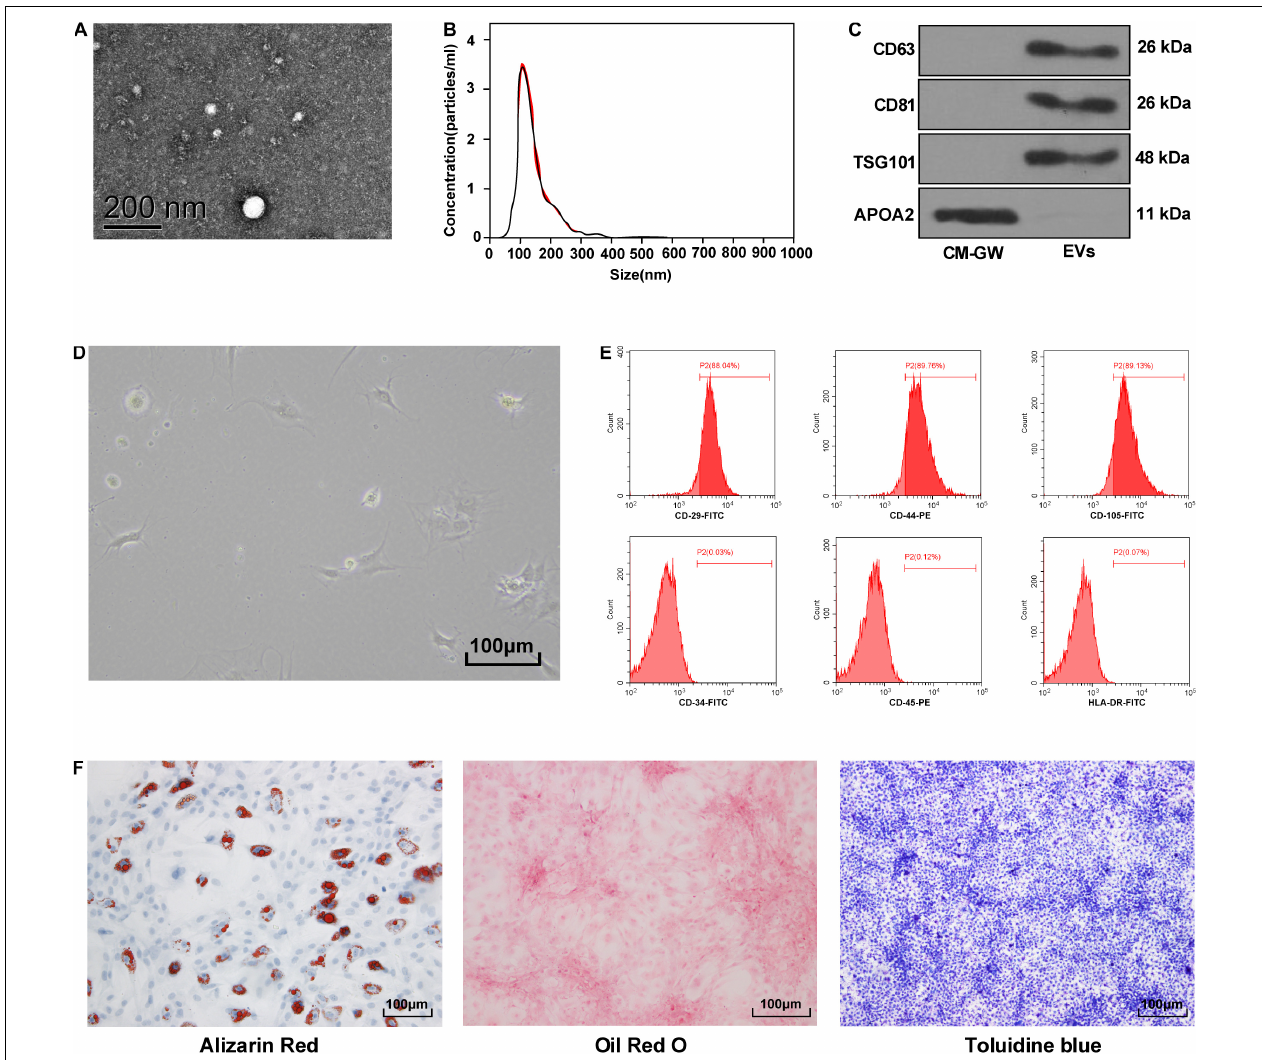
FIGURE 1 | Identification of BMSCs and hepatoma cell-derived EVs. (A) The morphology of EVs was observed by transmission electron microscopy. (B) The size and concentration of EVs were analyzed by nanoparticle tracking, the size was 110 ± 11 nm; the concentration was 4 × 10 6 particles/mL. (C) Western blot analysis detected the expression of specific marker proteins, and the conditioned medium of HepG2 cells treated with EV inhibitor GW4869 was used as the control. (D) The morphology of primary BMSCs was observed under an optic microscope. (E) The surface marker proteins of BMSCs was detected by flow cytometry, CD29/CD44/CD105 was positive, while CD34/CD45/HLA-DR was negative. (F) The differentiation potency of BMSCs was detected; from left to right, it is osteogenic differentiation, lipogenic differentiation, and chondrogenic differentiation. Stained color implied positive. Replicates = 3.